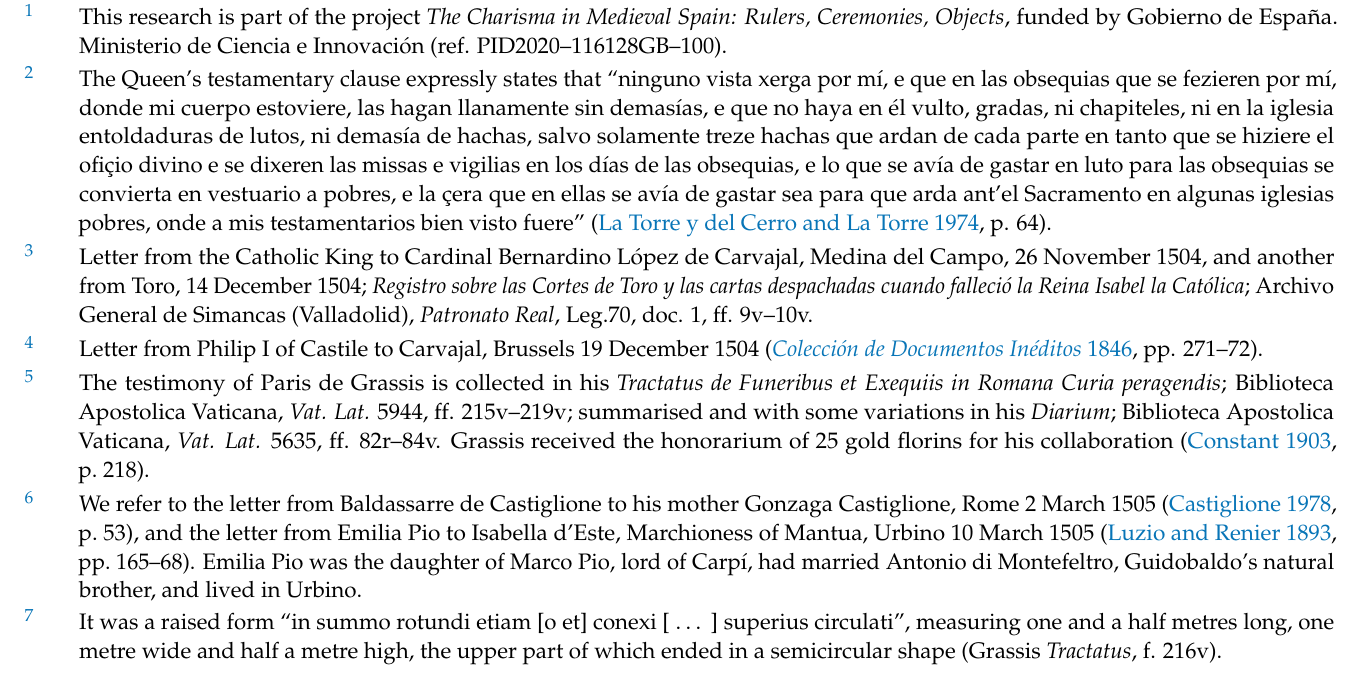
We refer to the letter from Baldassarre de Castiglione to his mother Gonzaga Castiglione, Rome 2 March 1505 (Castiglione 1978, p. 53), and the letter from Emilia Pio to Isabella d’Este, Marchioness of Mantua, Urbino 10 March 1505 (Luzio and Renier 1893, pp. 165–68). Emilia Pio was the daughter of Marco Pio, lord of Carp í , had married Antonio di Montefeltro, Guidobaldo’s natural brother, and lived in Urbino.